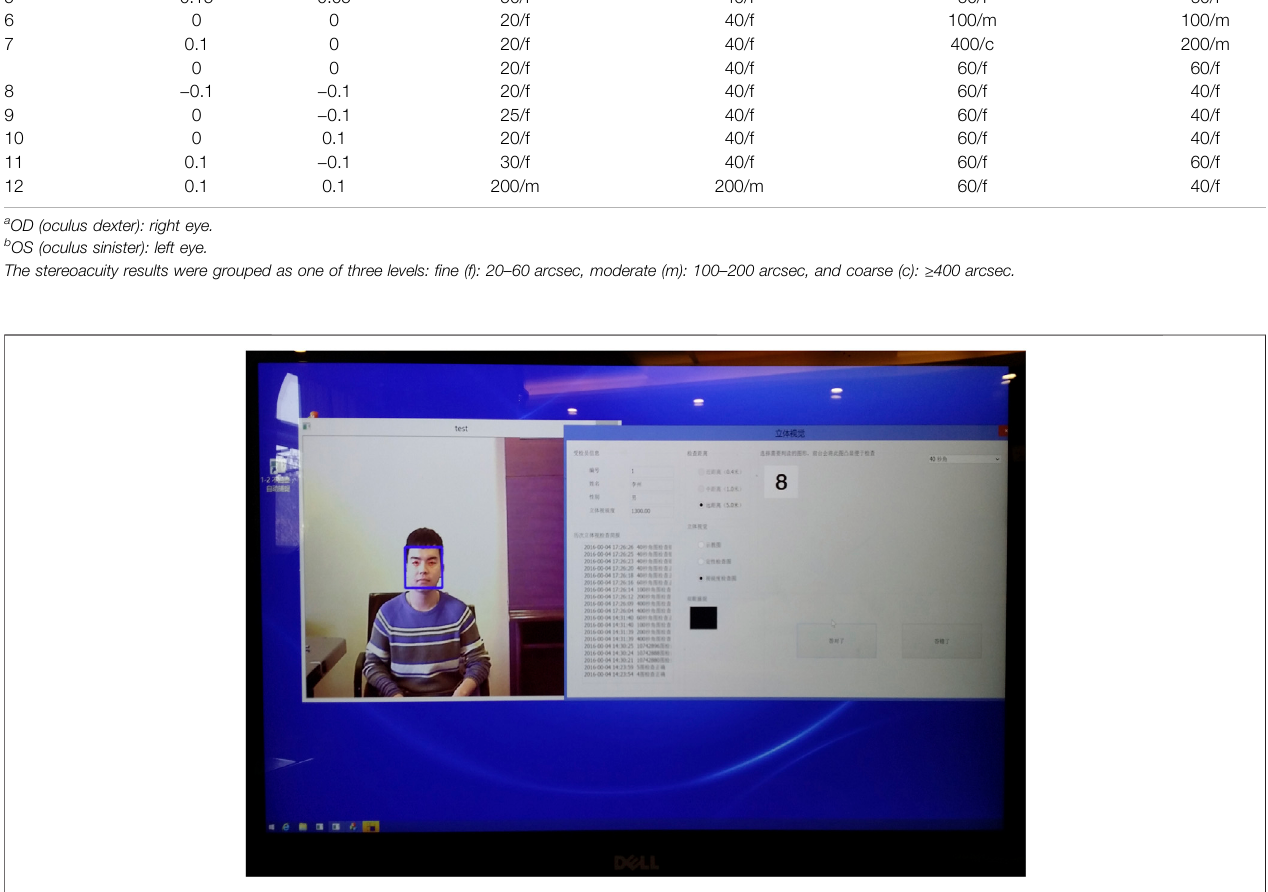
FIGURE 5 | The subject ’ s face (blue square) and both eyes (red circles) were located by the eye tracker.